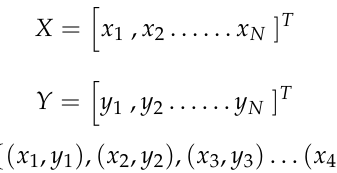
Figure 9. Code image from MSDP after application of DOG filter.